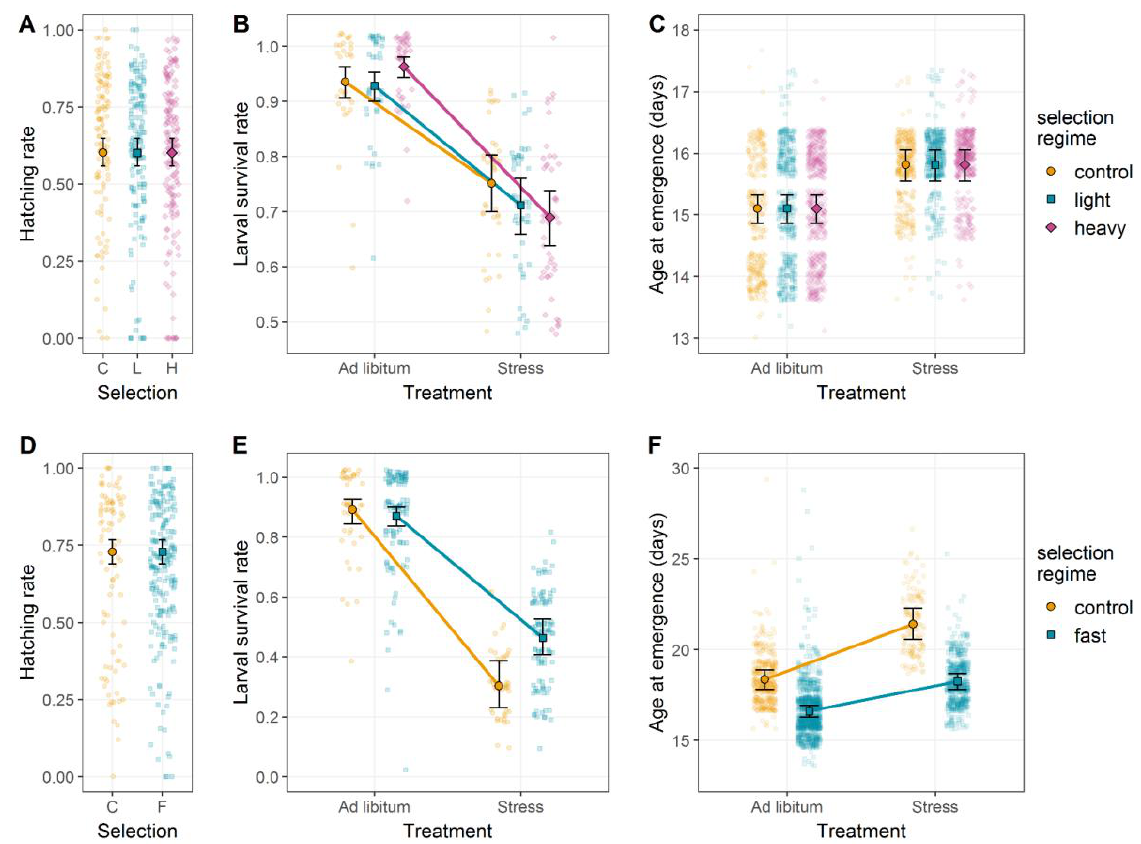
Figure 2: Juvenile phenotypic responses to selection on female body mass and age at first reproduction. Juvenile responses to female body mass selection on (A) hatching rate, (B) larval survival rate and (C) development time. While hatching rate and developmental time were not affected by the selection regime, larval survival rate depended on the interaction between selection regime and developmental environment. In addition, developmental environment had a significant influence on development time. Juvenile responses to age at first reproduction selection on (D) hatching rate, (E) larval survival rate and (F) development time. Hatching rate was not influenced by selection regime, but both larval survival rate and development time were significantly affected by the interaction between selection regime and diet. Color code is similar to Figure 1. Error bars represent standard errors between